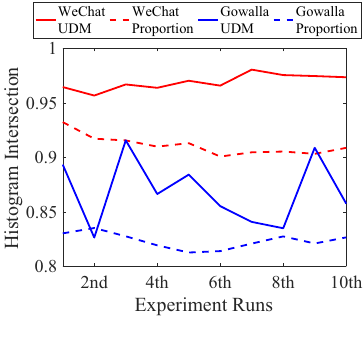
Figure 6. Performance of UDM on WM and